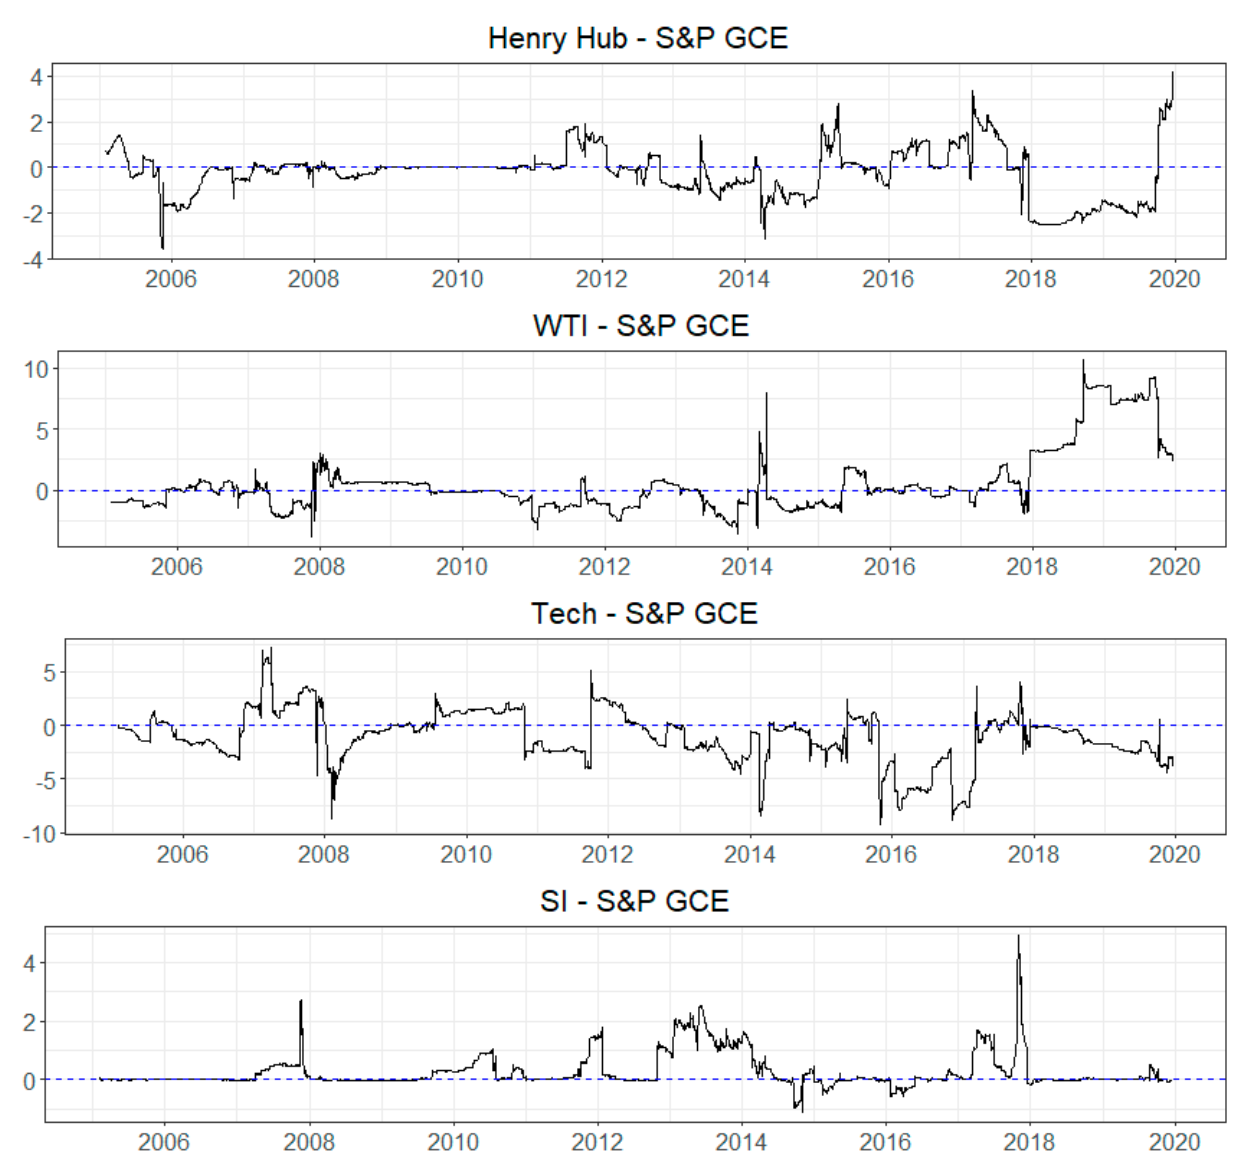
Figure A3. Dynamic net pairwise directional volatility connectedness (S&P GCE).